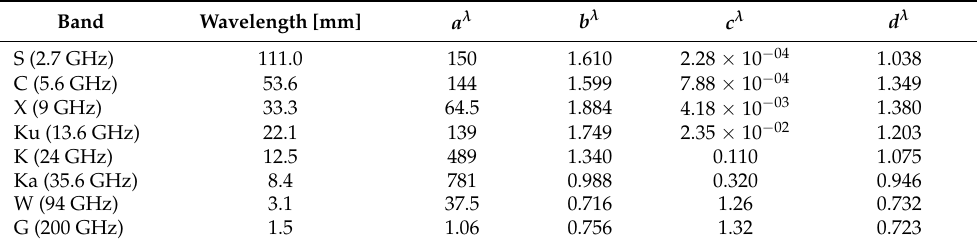
Figure 6. Power-law relationships of the form (6) and (7) derived from Parsivel measured raindrop size distributions for radar S-, C-, X-, Ku-, K-, Ka-, W-, and G-bands. ( a ) Radar effective reflectivity factor [dBZ] versus rain rate [mm h −1 ]; ( b ) rain specific attenuation [dB km −1 ] versus rain rate [mm h −1 ]. Power law coefficients are listed in Table 3. Table 3. Power-law coefficients for R -to- z λ e and R -to- k λ relationships with the form z λ e = a λ R b λ rain